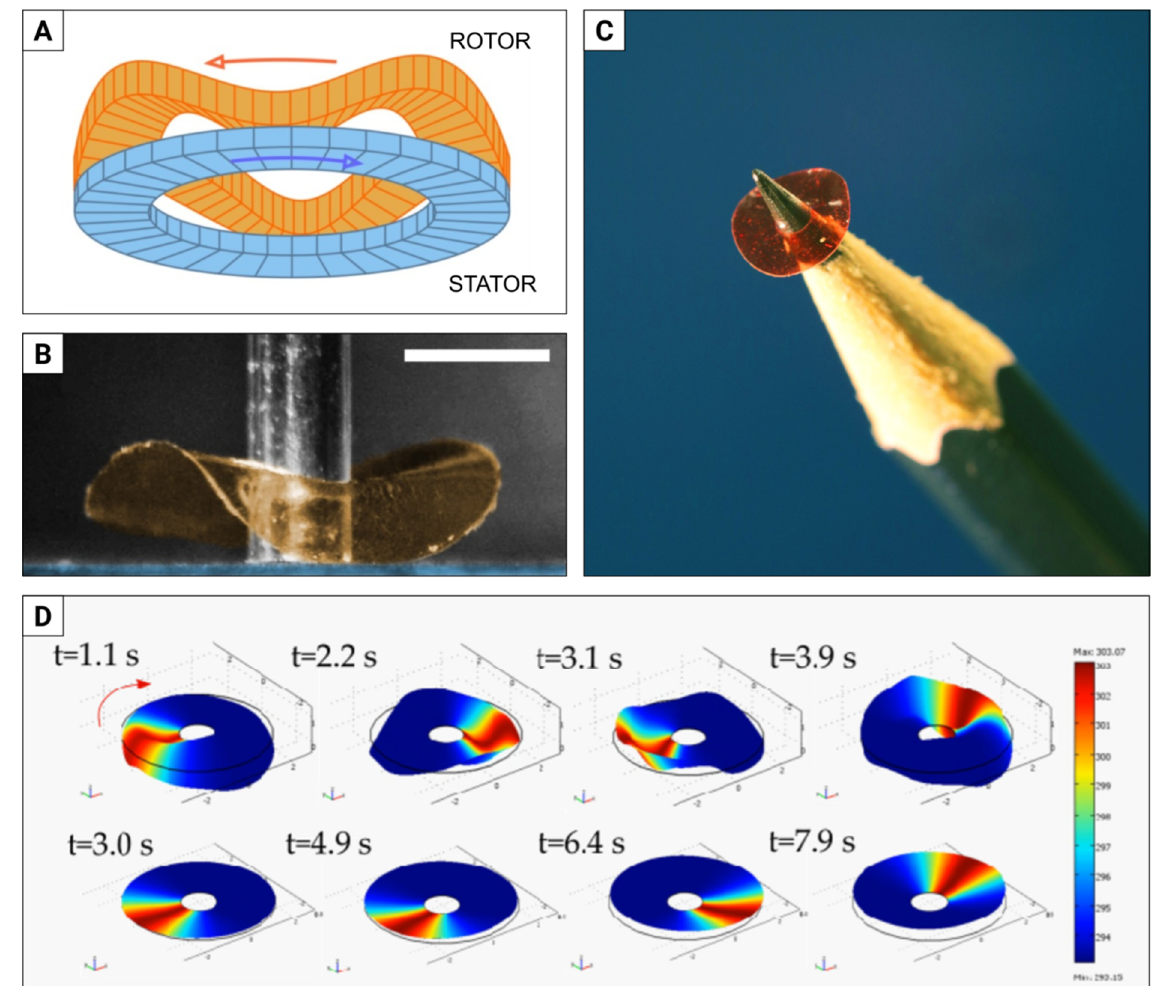
Figure 2. Rotary motor directly powered with light. ( A ) Schematic of the rotary piezoelectric (ultrasonic) motor. Travelling wave deformation generated in the rotor (orange) interacts via friction with the stator (blue) and sets the former in motion. ( B ) LCE rotary micro-motor, seen from the side. The LCE disc (rotor, orange) rotates with respect to the stator (rough solid surface, blue), around a steel axis. The white scale bar is 2 mm long. ( C ) The LCE rotor on a pencil tip for the scale demonstration (although, sadly, we must admit it cannot yet be used to sharpen pencils). ( D ) Numerical simulations of the LCE deformation upon illumination with a spatially modulated (rotating) laser beam. The top row is for azimuthal–radial, and the bottom row for azimuthal–azimuthal director orientation (see text for details). Adapted from [65].